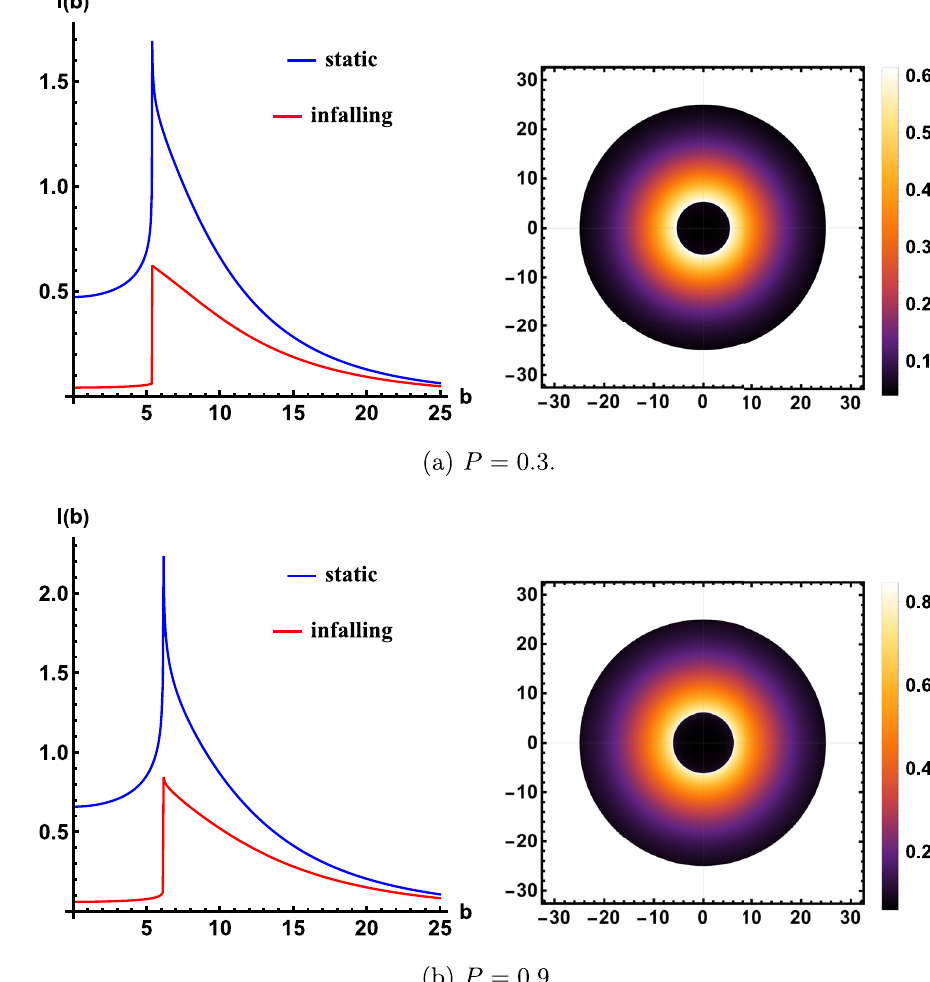
Fig. 9 The specific intensity I with respect to different impact parameters b in the left panels with static and infalling accretions for different P with fixed β = 0 . 1 and M = 1. And the shadows with these parameters for infalling accretions are shown in the right